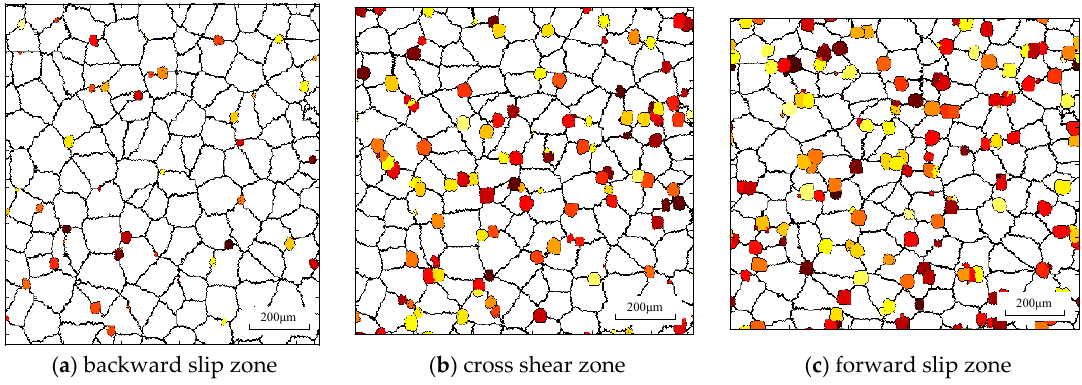
Figure 8. Microstructure under conditions i = 1.1 and S = 40 mm at the center point of the plate.